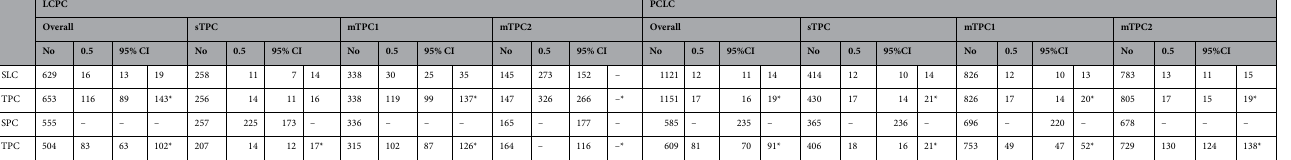
Table 3. Overall-survival of LCPC, PCLC and matched single lung/prostate cancer. Overall survival time of all LCPC, categorized group mTPC1 and mPTC2 were generally longer than that of matched single lung cancer, whereas overall survival time of all LCPC, categorized group sTPC and mPTC1 were shorter than that of matched single prostate cancer. For PCLC, overall survival time of all and the categorized groups were generally longer than that of matched single lung cancer and shorter than that of matched prostate cancer, respectively. LCPC lung cancer with subsequent prostate cancer; PCLC prostate cancer with subsequent lung cancer; TPC two primary cancer. ‘-’not reached. ‘*’indicated p value was <